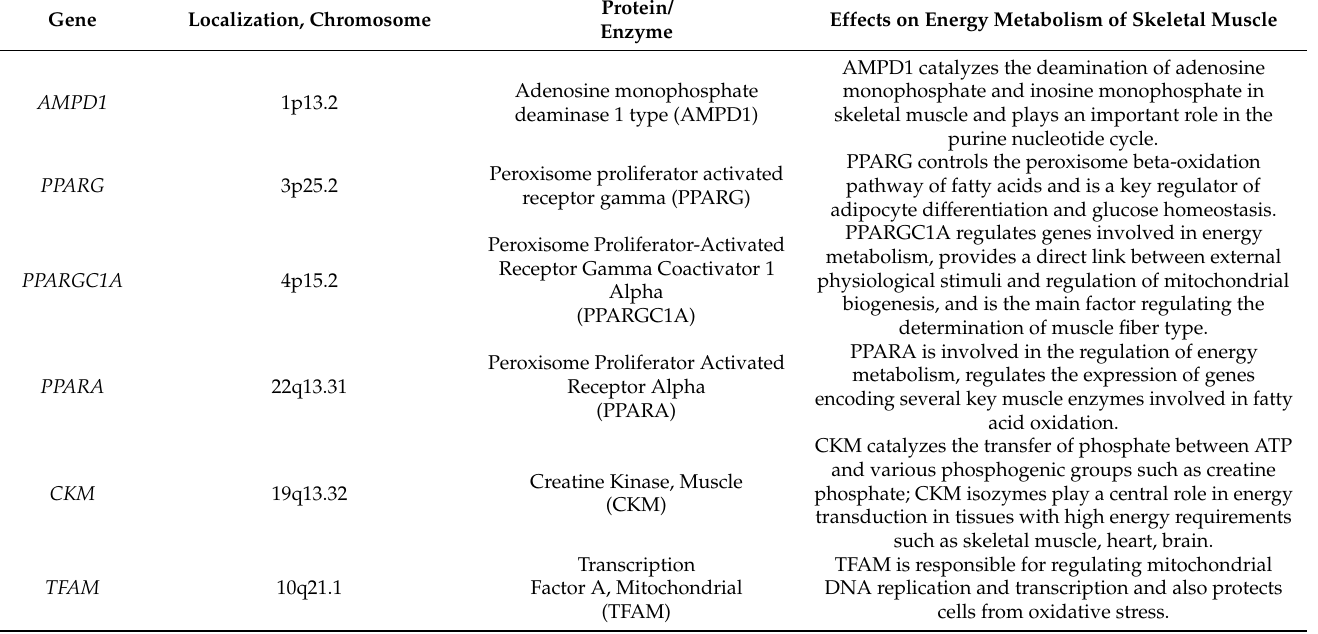
Table 2. Candidate genes and their encoded proteins and enzymes involved in the regulation of energy metabolism in skeletal muscles (adapted from [10]).